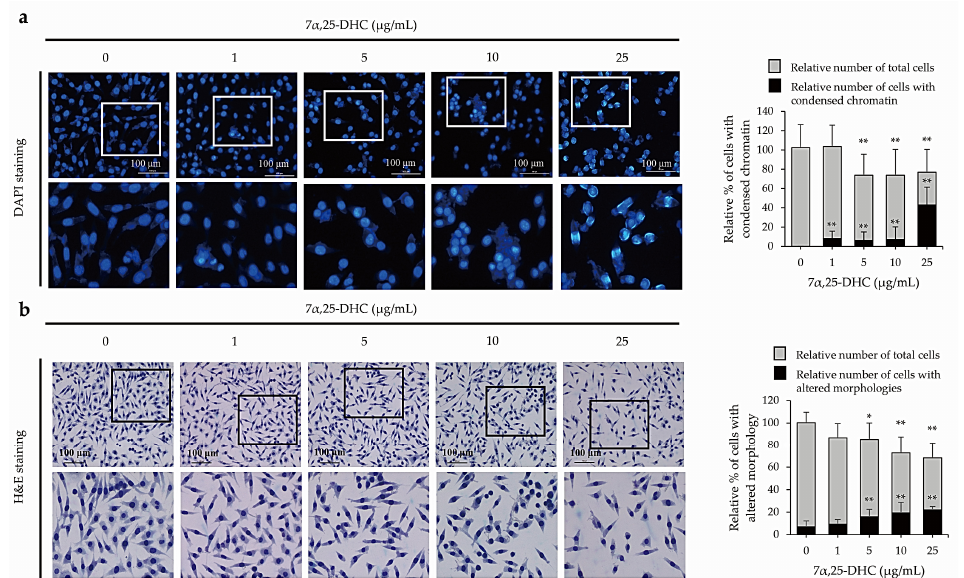
Figure 3. 7 α ,25-DHC induced apoptotic cell death in L929 cells. To verify the apoptotic characteristics, L929 cells were incubated with 1, 5, 10, and 25 µ g/mL 7 α ,25-DHC for 48 h. Thereafter, chromatin condensation and cell morphology were investigated by DAPI and H&E staining, respectively. ( a ) 7 α ,25-DHC enhanced the abundance of L929 cells with condensed chromatin. The nuclei of the cells were stained as blue fluorescence by DAPI. Relative % of total cells (gray color) were counted by cells with condensed chromatin and intact chromatin. Thereafter, relative % of cells with condensed chromatin (black color) was calculated by (number of cells with condensed chromatin/(number of cells with condensed chromatin + number of cells with intact chromatin) × 100). ( b ) Cells with an altered morphology were increased in L929 cells incubated with 7 α ,25-DHC. Relative % of total cells (gray color) was counted by cells with both altered and intact morphologies. Thereafter, relative % of cells with altered morphologies was calculated by (number of cells with altered morphology/(number of cells with altered morphology + number of cells with intact morphology) × 100). Results